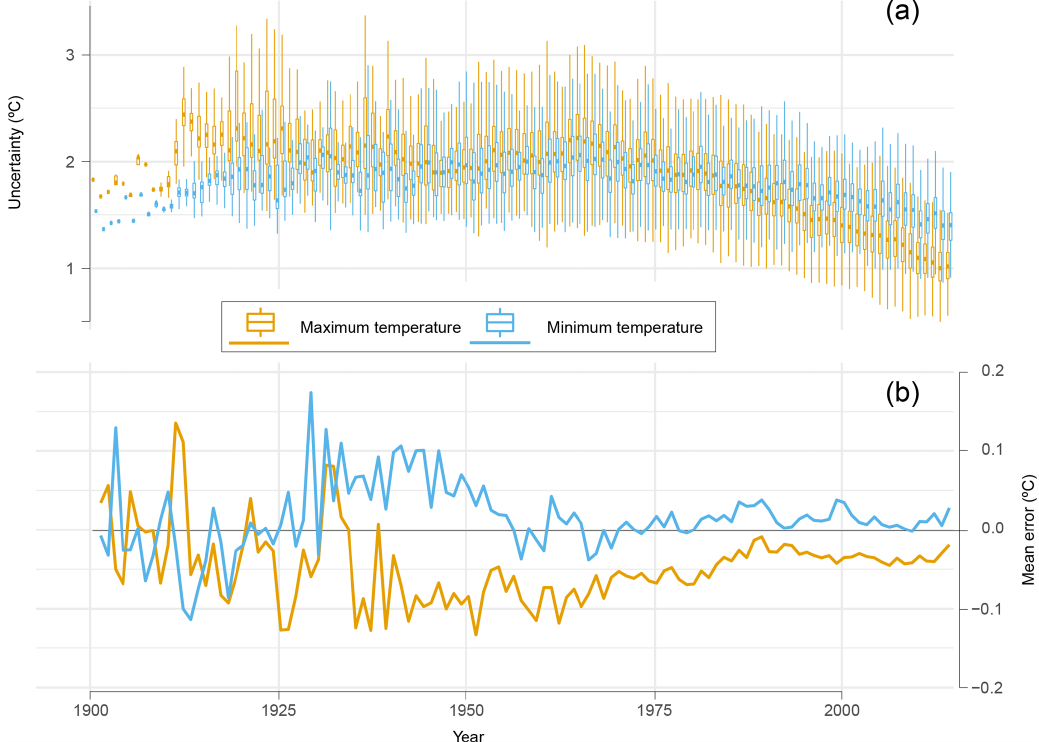
Figure 11. Annual evolution of median daily uncertainty (a) and mean error (b) of maximum and minimum temperature in peninsular